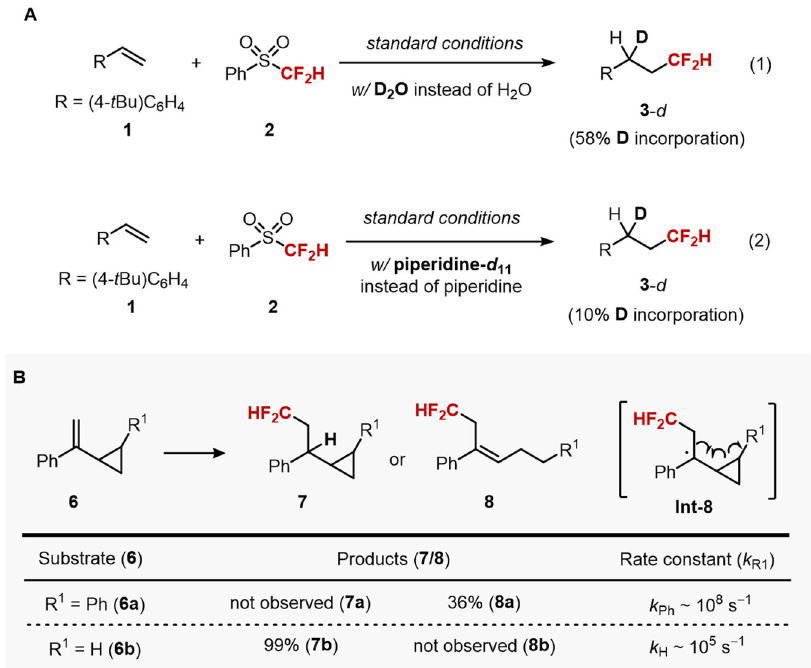
Fig. 4 Preliminary mechanistic investigation. A A signi fi cant amount of deuterium incorporation was observed upon employment of D 2 O in under optimized reaction conditions (Eq. 1). The reaction with piperidine- d 11 result in low deuterium incorporation (Eq. 2). B Vinyl cyclopropane 6a with higher ring opening rate constant ( k Ph = ~10 8 s − 1 ) underwent rupture of the three-membered ring (8a), while the cyclopropyl ring in 6b ( k H = ~10 5 s − 1 ) remained intact after